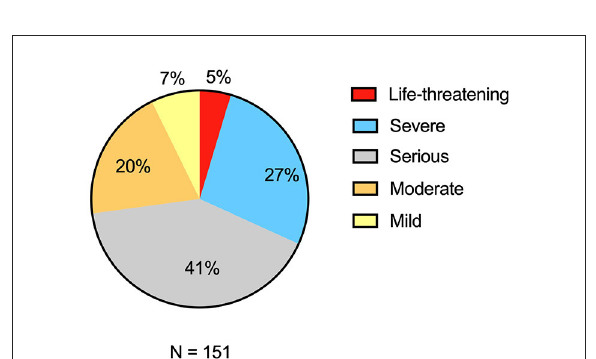
FIGURE2 Severity of the first attack of NMOSD. Patients reported severity of first events to range from mild to life-threatening. NMOSD indicates neuromyelitis optica spectrum